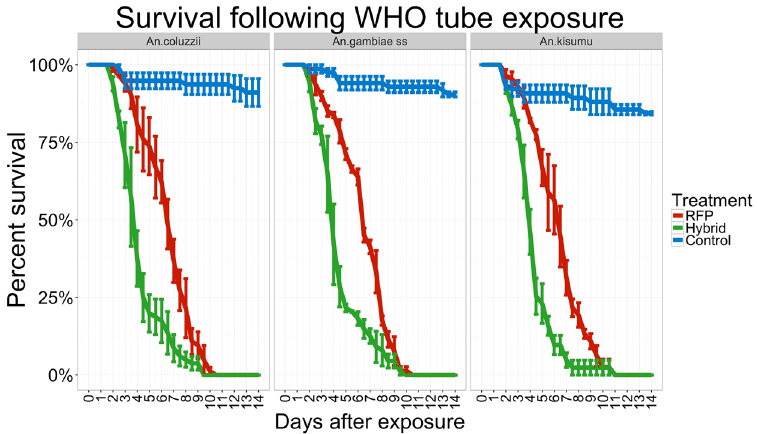
Figure 2. Survival following WHO tube exposure: these three graphs represent survival curves for RFP expressing Metarhizium (Met-RFP) and Hybrid toxin-expressing Metarhizium (Met-Hybrid) against two wild-caught, insecticide-resistant ( An. coluzzii and An. gambiae s.s.) and one lab-reared ( An. gambiae Kisumu ) human malaria vector mosquitoes. There are no significant differences in time to kill insecticide resistant and susceptible strains, but Met-Hybrid is more effective on all mosquito